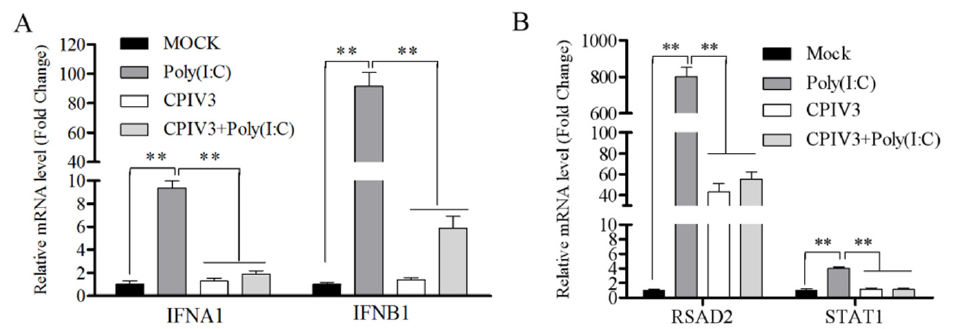
Figure 1. CPIV3 infection inhibited the activation of endogenous type I IFNs in MDBK cells. ( A ) CPIV3 infection inhibited the transcription of IFNA1 and IFNB1 in virus-infected and poly(I:C)-stimulated cells. ( B ) CPIV3 infection inhibited mRNA levels of RSAD2 and STAT1 stimulated by poly(I:C). MDBK cells were infected with CPIV3 at an MOI of 1 for 48 h, poly(I:C) transfection was used as a positive control, and the uninfected cells were used as the negative control. Then, CPIV3-infected cells or CPIV3-infected poly(I:C)-transfected cells were harvested, and the relative quantitation values for IFNA1 , IFNB1 , RSAD2 , and STAT1 mRNA were determined by qPCR assay. Error bars indicate standard error of mean (SEM) of two independent experiments. *, p < 0.05, **, p < 0.01.